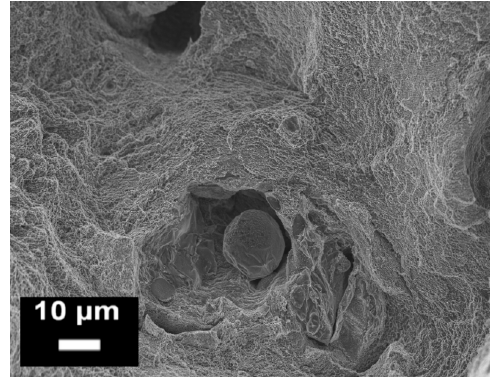
Figure 16. Example of an un-melted powder particle inside an SLM AlSi10Mg tensile sample observed at by FESEM (from the authors’ own unpublished work).